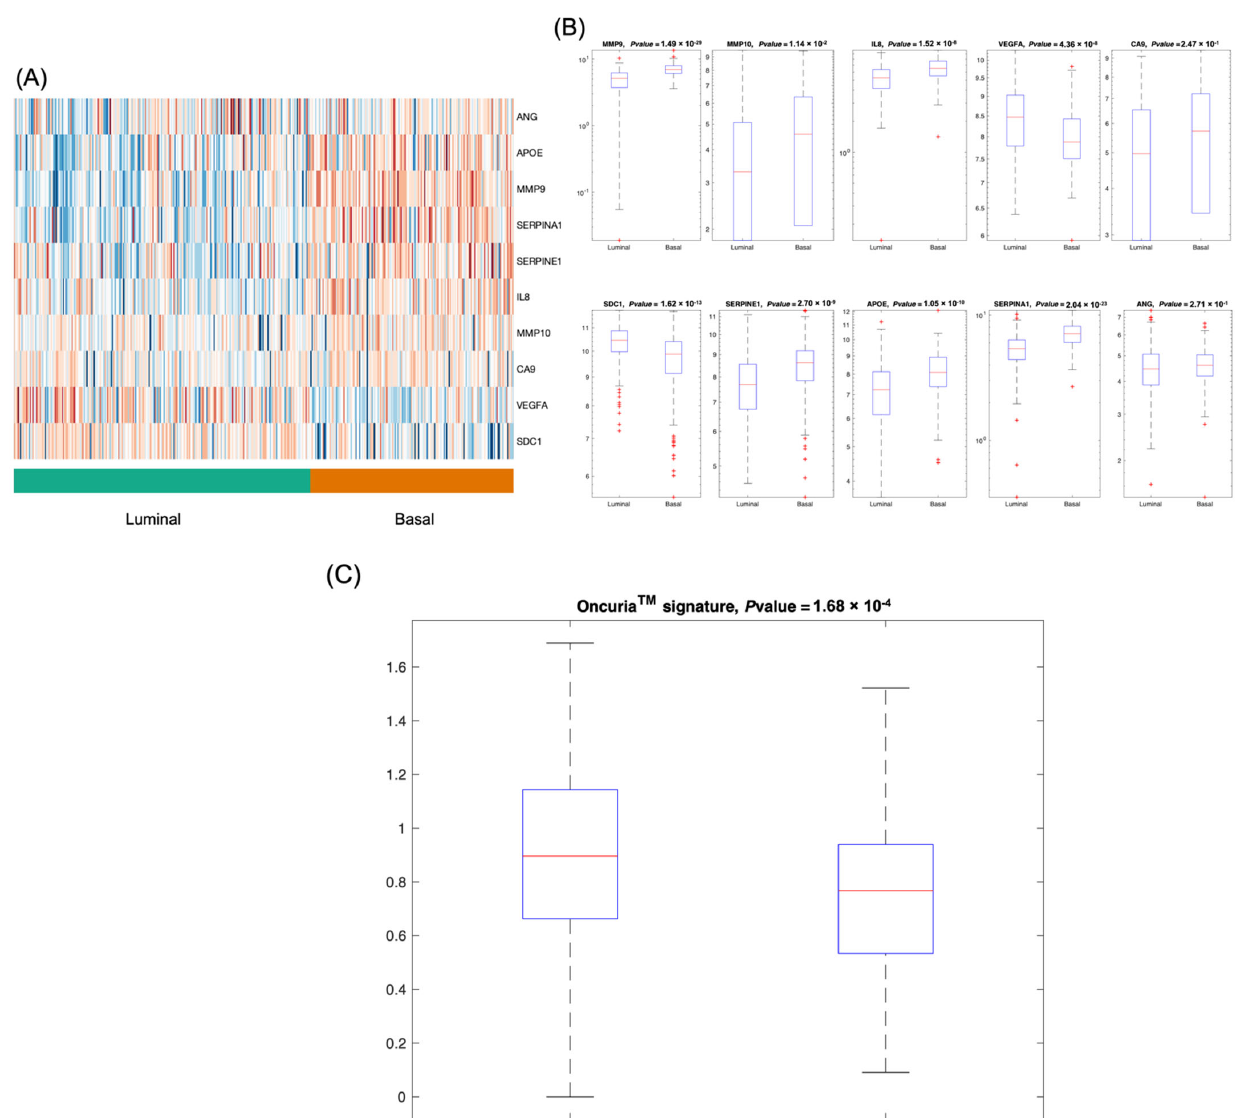
Figure 1. Correlation of the 10 biomarkers associated with Oncuria™ with luminal vs. basal tumors. ( A ) Heatmap illustrating application of each of the 10 biomarkers associated with Oncuria™ in stratifying luminal vs. basal tumors within the TCGA cohort. Blue to brown shows a trend from low to high gene expression. ( B ) Gene expression results of the individual biomarkers from the bladder cancer signature related to luminal vs. basal subtype. ( C ) Oncuria TM combined signature is related to luminal vs. basal subtype.